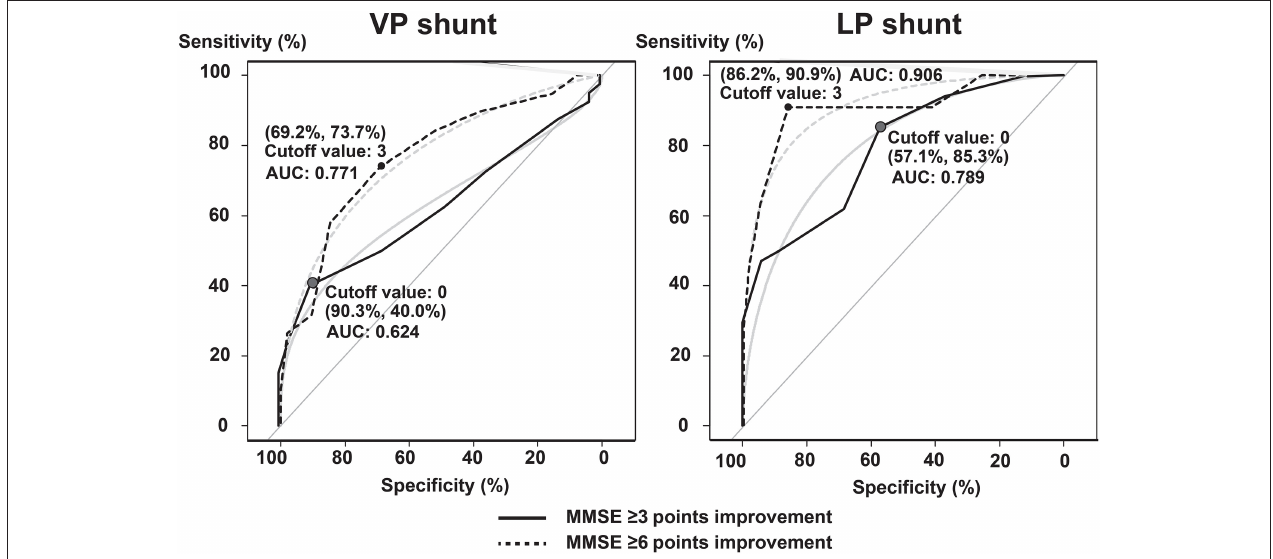
FIGURE 5 | Tap test as predictor of postoperative MMSE scores. The optimal threshold, sensitivity, and specificity of the MMSE score during the tap test to predict MMSE improvement at 12 months after shunting have been analyzed using receiver operating characteristic analysis. The light blue line shows the approximate line. AUC, area under the receiver operating characteristic curve; MMSE, Mini-Mental State Examination; LP, lumboperitoneal; and VP,